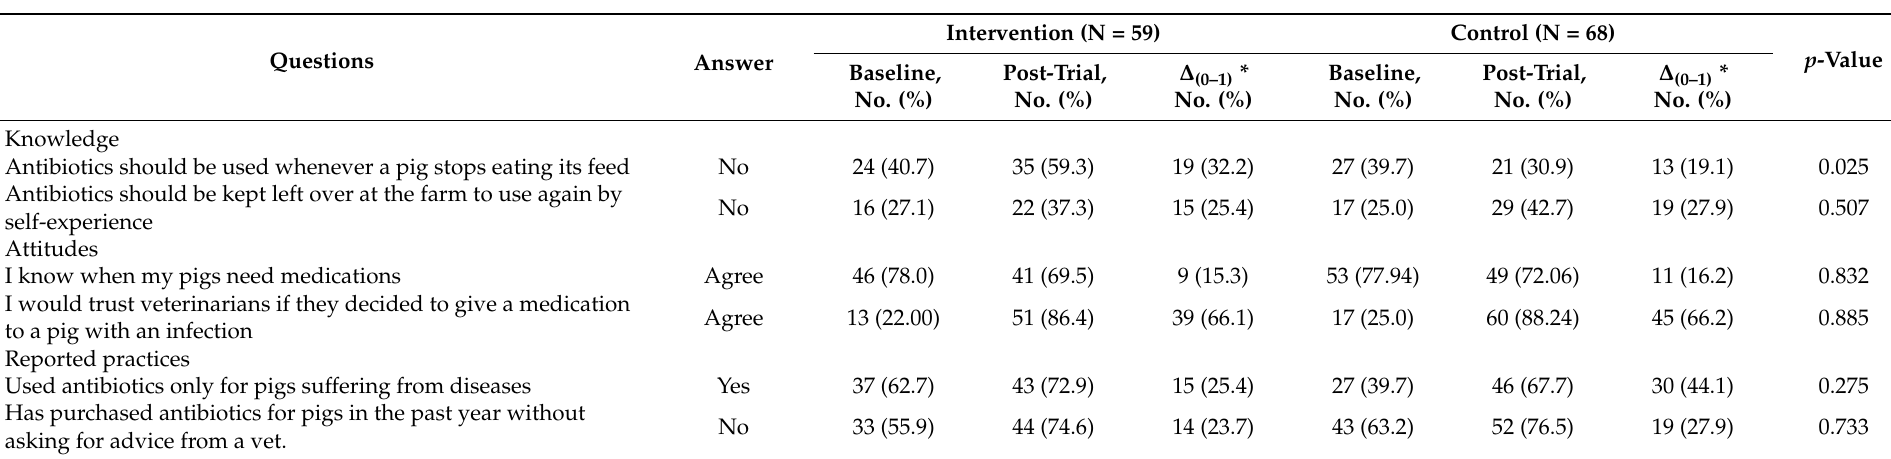
Table 3. Effect of intervention on knowledge, attitudes and reported practices on antibiotic use in